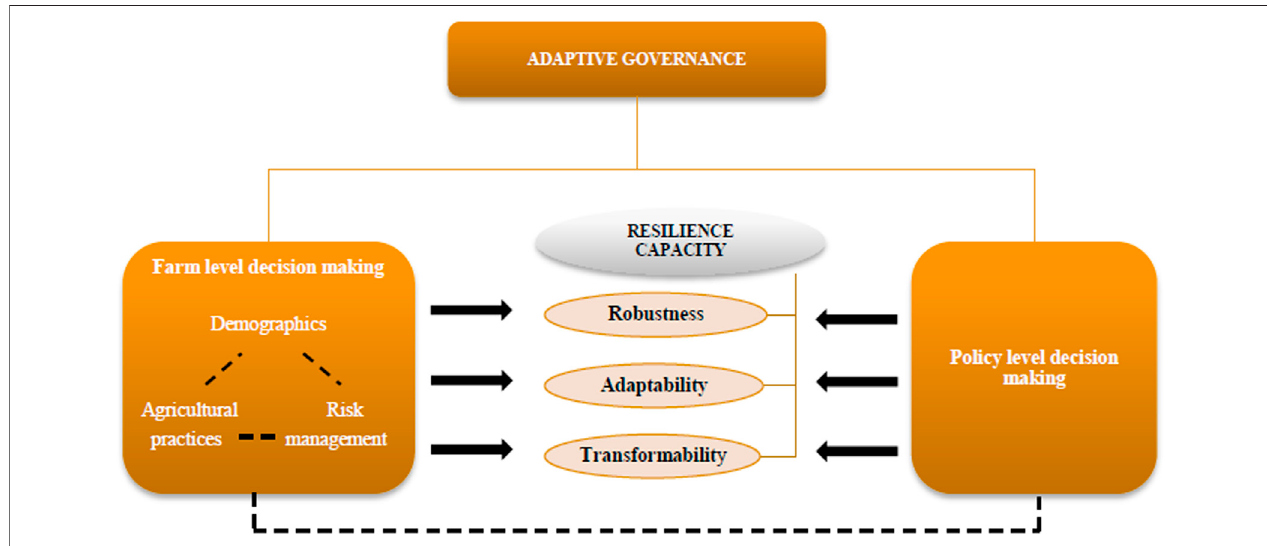
FIGURE 1 | Adaptive governance processes: farm level and policy level adaptive processes in fl uencing the resilience capacity of farms.